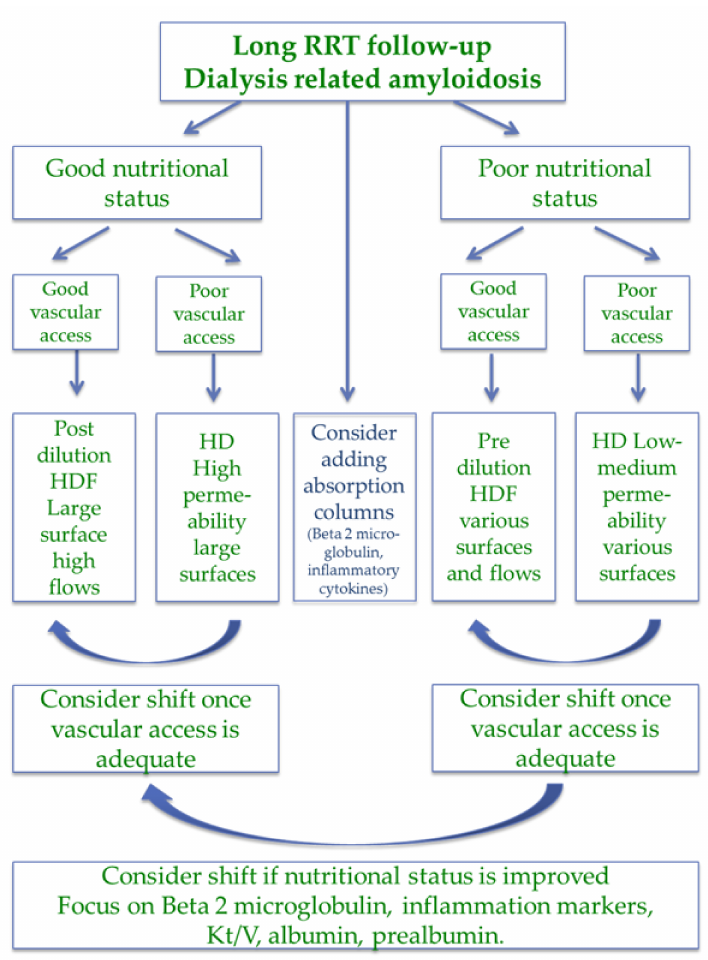
Figure 5. Choice of dialysis (hemodialysis (HD) or hemodiafiltration (HDF)) in the patients with long-term follow-up on renal replacement therapy